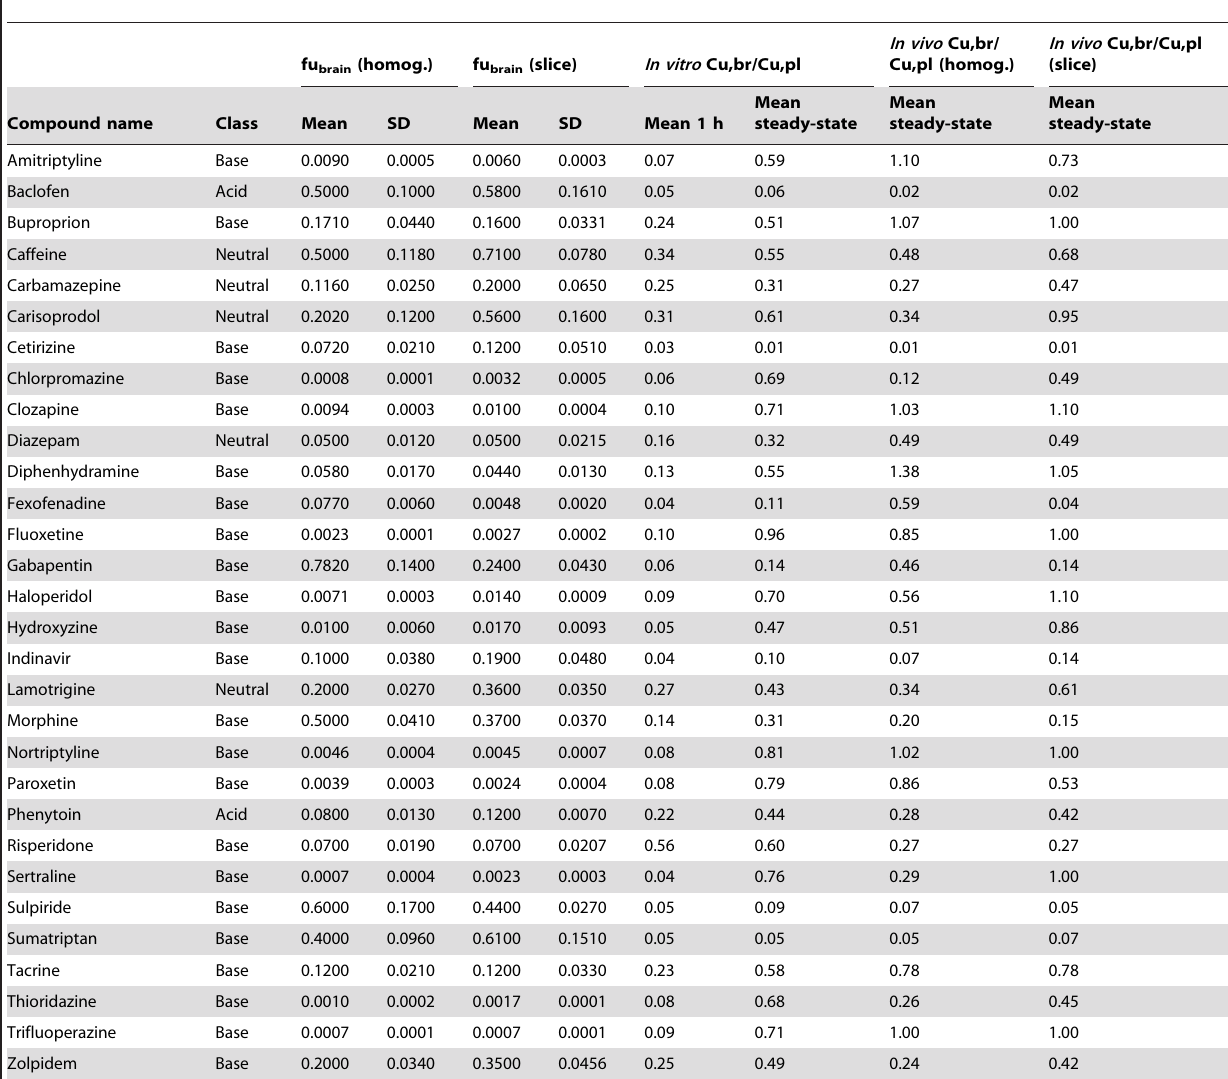
Table 2. Brain unbound fractions obtained using either the brain slice or the brain homogenate method and in vitro and in vivo unbound brain/plasma ratios of 30